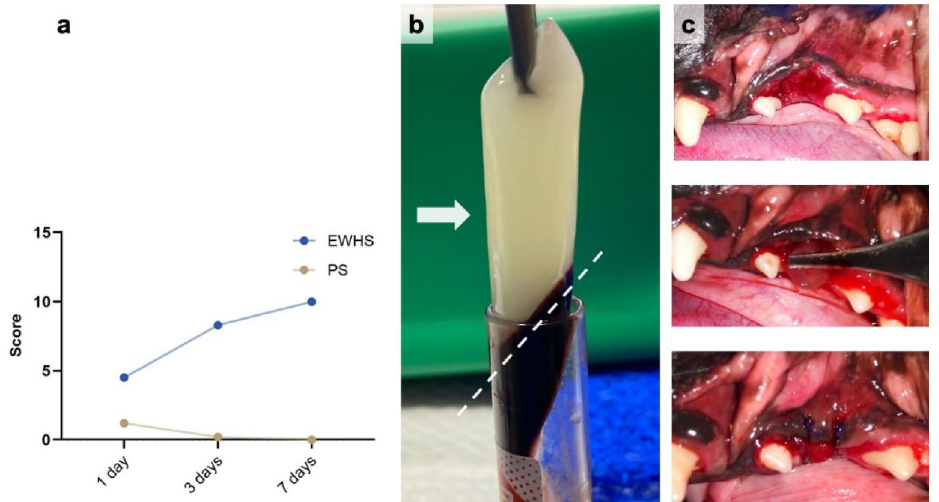
Figure 5. ( a ) Results of average EWHS and PS after one, three and seven days in patients with PRF included in the post-extraction wound site. ( b ) PRF sample (marked with arrow) and separation site from the bottom layer of red blood cells (marked with dashed line). ( c ) PRF membrane positioning and fixation in post-extraction wound site after creating a mucosal